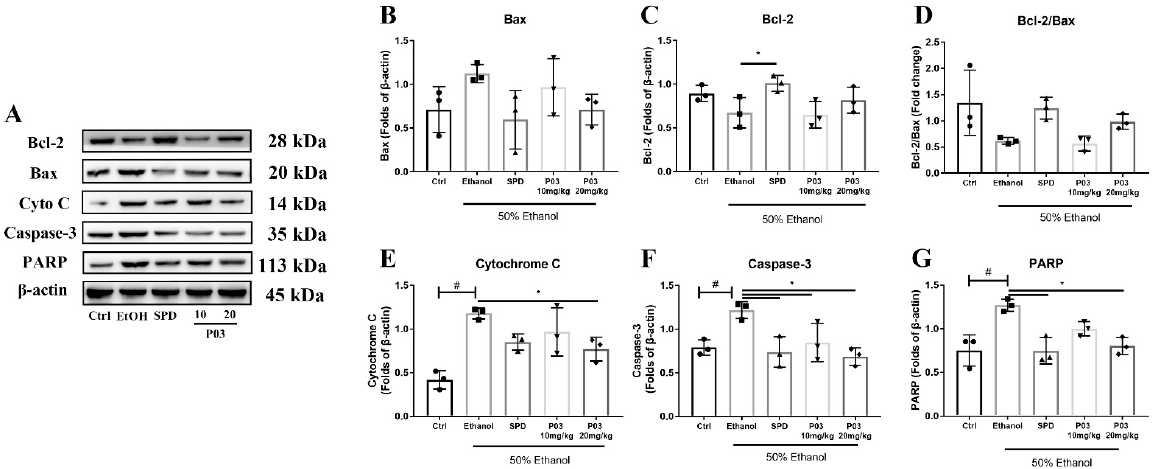
Figure 8. Immunoblots of Bcl-2, Bax, Cytochrome C, Caspase-3 and PARP. ( A ) Immunoblots of indicated proteins. ( B – F ) Densitometric quantification of Bcl-2, Bax, Cytochrome C, Caspase-3 and PARP were performed and normalized to β -actin levels. ( G ) The ratios of Bcl-2 vs. Bax were calculated from densitometric analysis. The values represent mean ± SD and are plotted as fold- change. (Compared to Ctrl, # p < 0.05. Compared to ethanol, * p < 0.05) ( n =